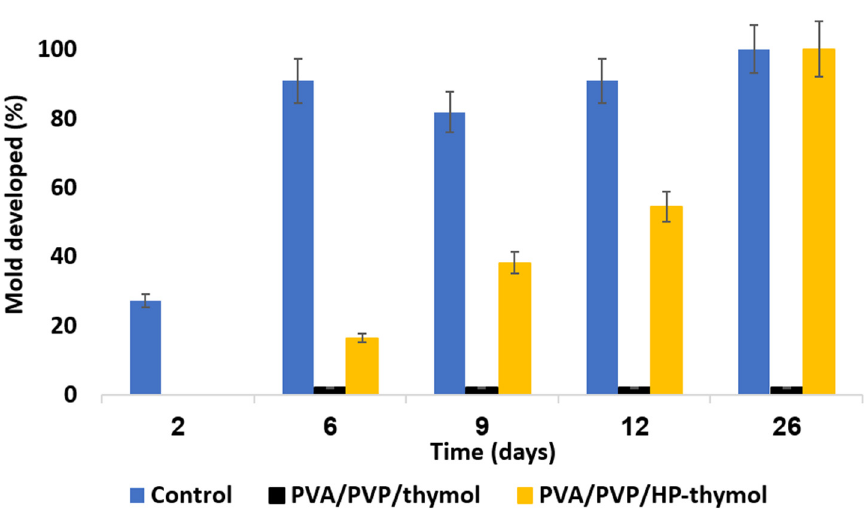
Figure 11. Mold growth rate over several days as a function of coating type. The PVA/PVP hydrogel PE coated sheets (blue) are a control. PE sheets coated with PVA/PVP/thymol (1.25 w% thymol precursor, black) or PVA/PVP/HP-thymol (0.63% each of HP and thymol precursors, orange) present coatings with entrapped anti-mold components.